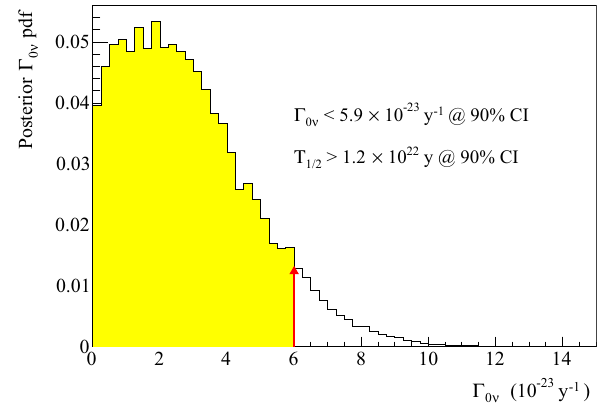
Fig. 7 Posterior p.d.f. of the decay rate. Yellow: integral of the pos- terior up to 90%. The red arrow indicates the value of the decay rate corresponding to the 90% credible